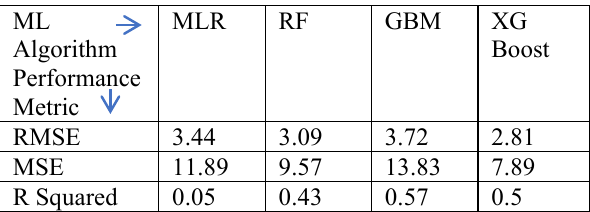
Table 3. Results for the month of August 2018 ML